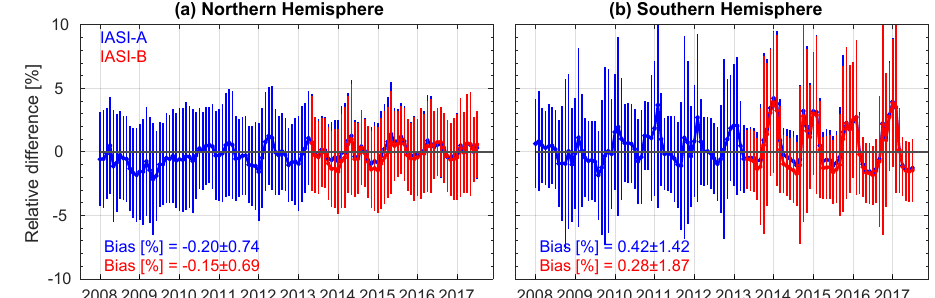
Figure 8. Monthly relative differences (in percent) between IASI-A (blue) and IASI-B (red) against GOME-2A total ozone column prod- ucts as a function of time for the 2008–2017 period for the Northern Hemisphere (a) and the Southern Hemisphere (b) . The 1 σ stan- dard deviation of the relative differences is also displayed (vertical bars). For each 1 ◦ × 1 ◦ grid cell, a relative difference is calculated as 100 × (IASI − GOME-2) / GOME-2 [%]. All the relative differences in each hemisphere are then monthly averaged. Comparison statistics including the mean bias and its 1 σ standard deviation in percent for the 2008–2017 period (IASI-A) and the 2013–2017 period (IASI-B) are indicated on each